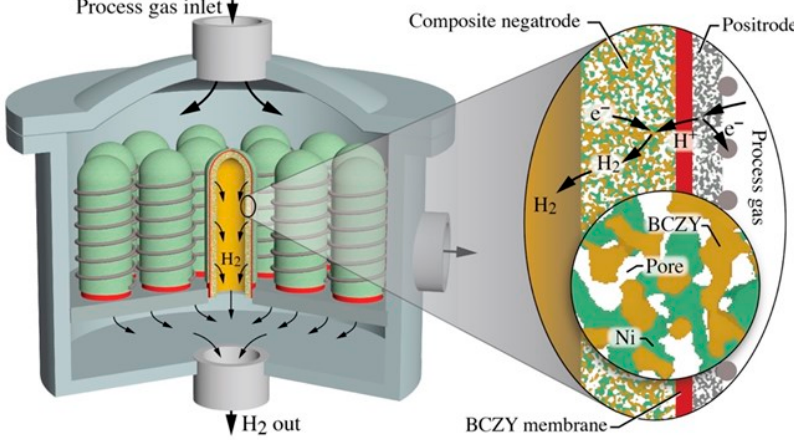
Figure 9. Cartoon illustration of a possible protonic ceramic membrane reactor concept. A bank of short, closed-ended tubes is bonded to a collection manifold. A steady flow of process-gas mixture enters at the top. Flowing process gases and reaction products occupy the reactor volume outside protonic ceramic tubes and exhaust laterally. The expanded figure on the right illustrates details of the tubes’ membrane-electrode assembly and its electrochemical function.